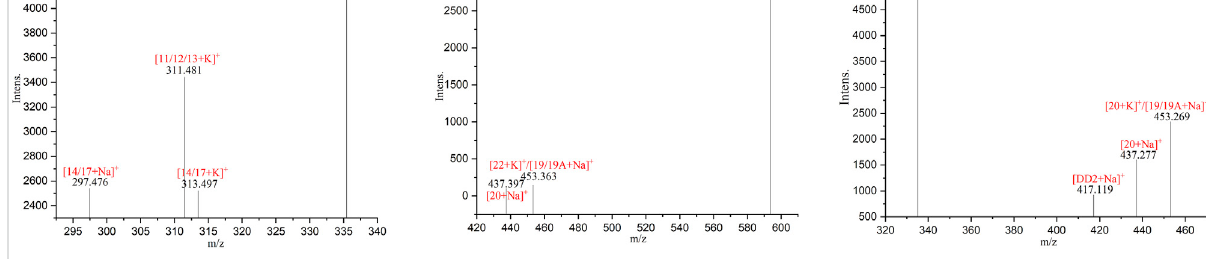
FIGURE 5 MALDI-TOF MS spectra of the mice lungs dosed with D1 (A) , DD2 (B) , and DD3 (C) .